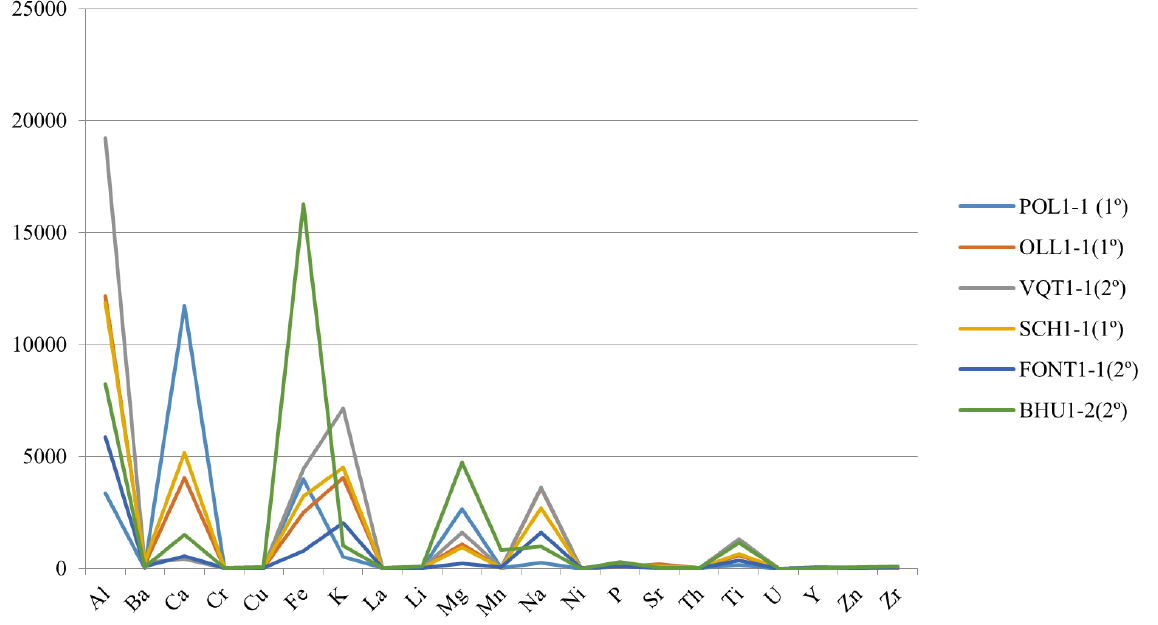
Figure 7: Graphic of the elemental content from the samples analysed via ICP-OES. Quantities are in ppm.